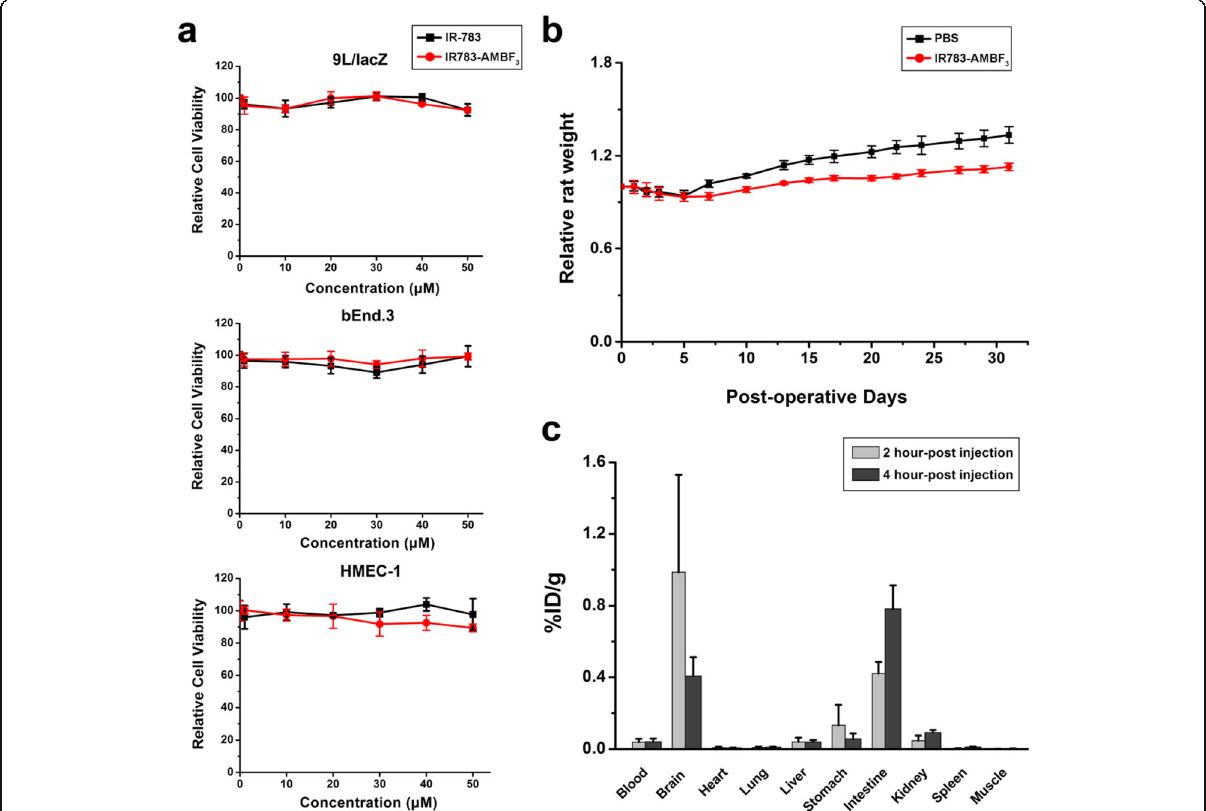
Fig. 4 Safety studies of IR783-AMBF 3 . a Effect of IR783-AMBF 3 on murine gliosarcoma (9 L/lacZ), murine endothelioma (bEnd.3) and human microvascular endothelial (HMEC-1) cell viability. Cells were treated with different concentrations of IR-783 (black line) or IR783-AMBF 3 (red line) for 24 h. b Relative mean weight of rats after intrathecal injection of IR783-AMBF 3 at 150 μ M ( n = 4). Error bars are ± SD. c Biodistribution data collected in different tissues shows that intrathecally injected IR783-AMBF 3 clears from the CSF and blood quickly and is ultimately excreted and through the renal and hepatic systems ( n = 3). Error bars are ±